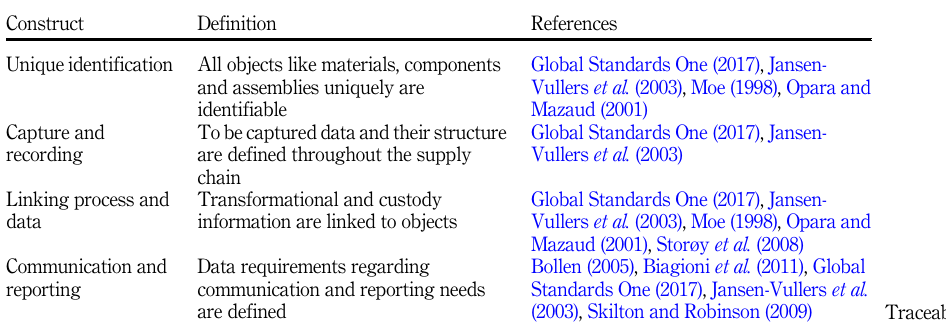
Table 1. Traceability